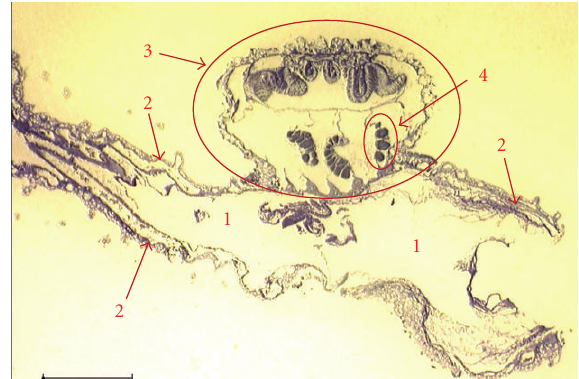
Figure 12: A section of Paracorallium japonicum ; OCA- Cn20060109-042 with a commensal zoanthid, Corallizoanthus tsukaharai. 1: host axis, 2: host coenenechyme, 3: polyp of commensal zoanthid, 4: gonads of commensal zoanthid. Scale bar is 1.0mm.